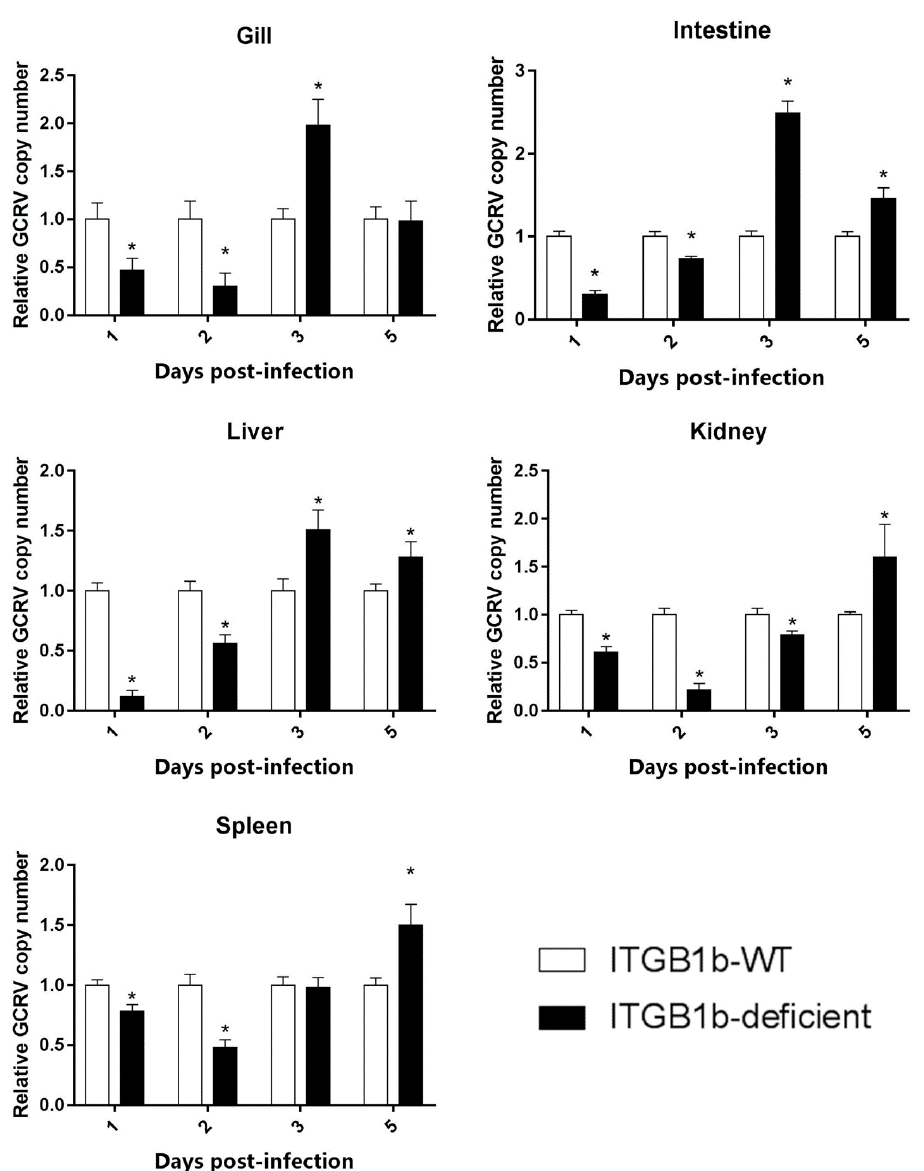
Figure 4. A relative number of GCRV copies in vivo. The relative number of GCRV copies was expressed as the ratio of the level of GCRV S6 segment expression in ITGB1b-deficient fish relative to that of wild-type fish at each time-point. A significant difference ( p < 0.05, ANOVA) in the number of viral copies between the samples from wild-type and ITGB1b-deficient rare minnows is indicated with an asterisk (*).